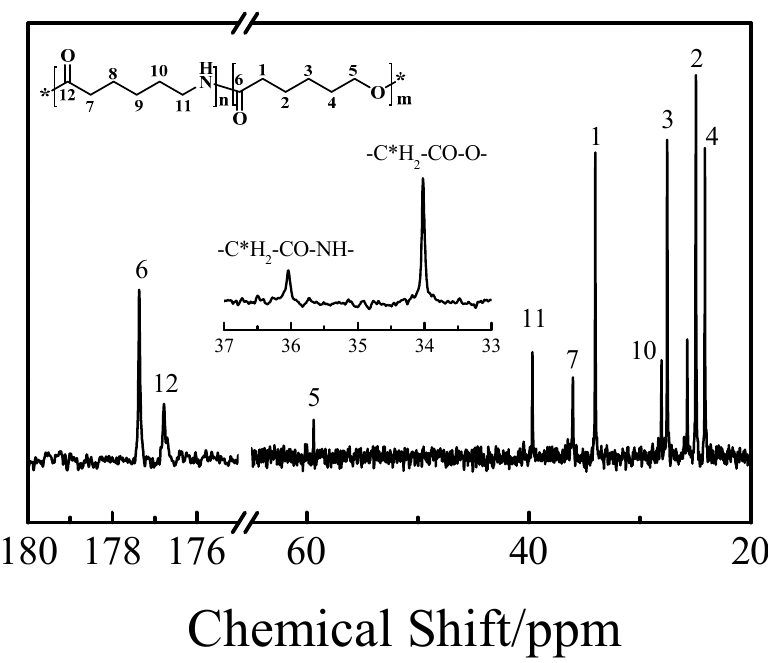
Figure 2. 13 C NMR spectrum of C 50 -co- A 50 . The insert is the expansion of the 33–37 ppm chemical shift. (solvent: 50/50 (volume ratio) CDCl 3 /HFIP, 400 MHz).